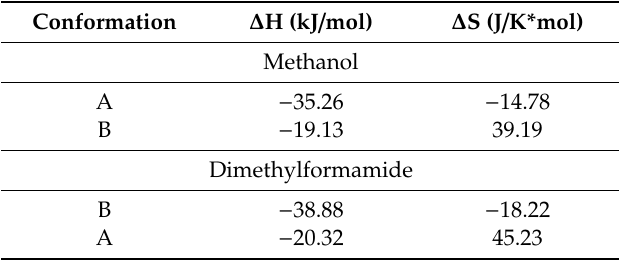
Table 4. Thermodynamic parameters associated to the complex formation of 1 with 6 in methanol or the DMF solvent simulated by the TIP3P solvent model.